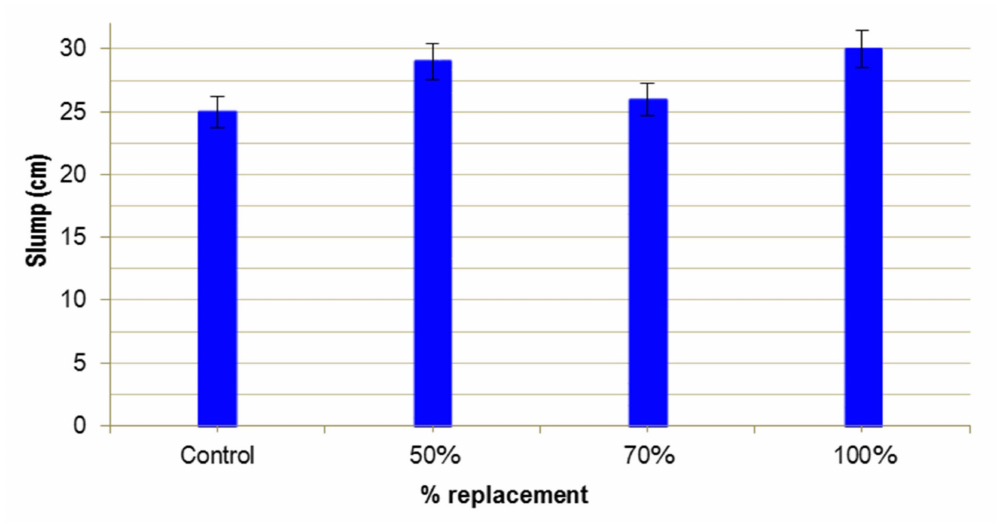
Figure 4. Slump of